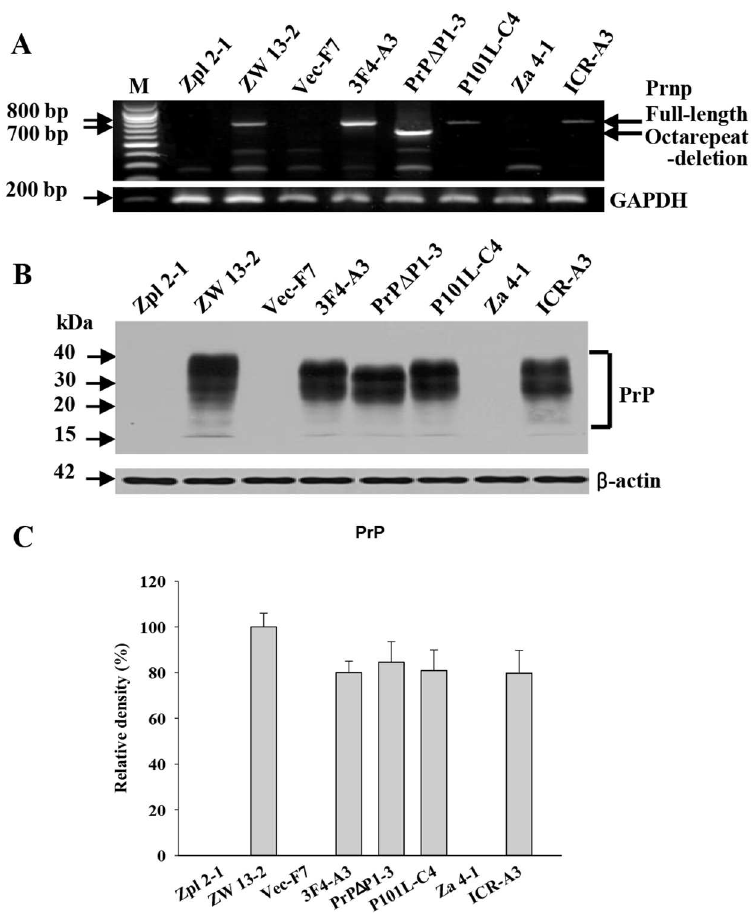
Fig 1. Expression levels of the PrP C genes and proteins in neuronal and astroglial cell lines. (A) Analysis of expressionlevels of Prnp in Prnp -/- , Zpl, Vec, and Za, and Prnp +/+ , ZW, 3F4, PrP Δ , P101L, and ICR cell lines. ZW, 3F4, P101L,and ICR-A cell lines containedfull-lengthof Prnp (789 bp). Cell lines expressingwild-typePrP C are calledthe ZW cell line (Table 1). PrP Δ cell line containedshorter length Prnp (663 bp). Zpl, Vec, and Za cell lines were negativefor Prnp detection. (B) Protein levels of PrP in cell lines were consistent with the results of RT-PCR analysis. PrP Δ cell line showedshorter length PrP. (C) Densitometry analysisof PrP protein expressionshowedno significantdifference betweenwild-typecells and PrP-transfected cells. Relativevalues are represented as the mean ± SEM. Cell lines were assessedby three separateexperiments. ZW 13–2, 100 ± 7.82;3F4-A3, 87.8 ± 9.53;PrP Δ P1-3, 93.8 ± 9.11;P101L-C4, 83.94 ± 9.41; ICR-A3, 88.75 ±